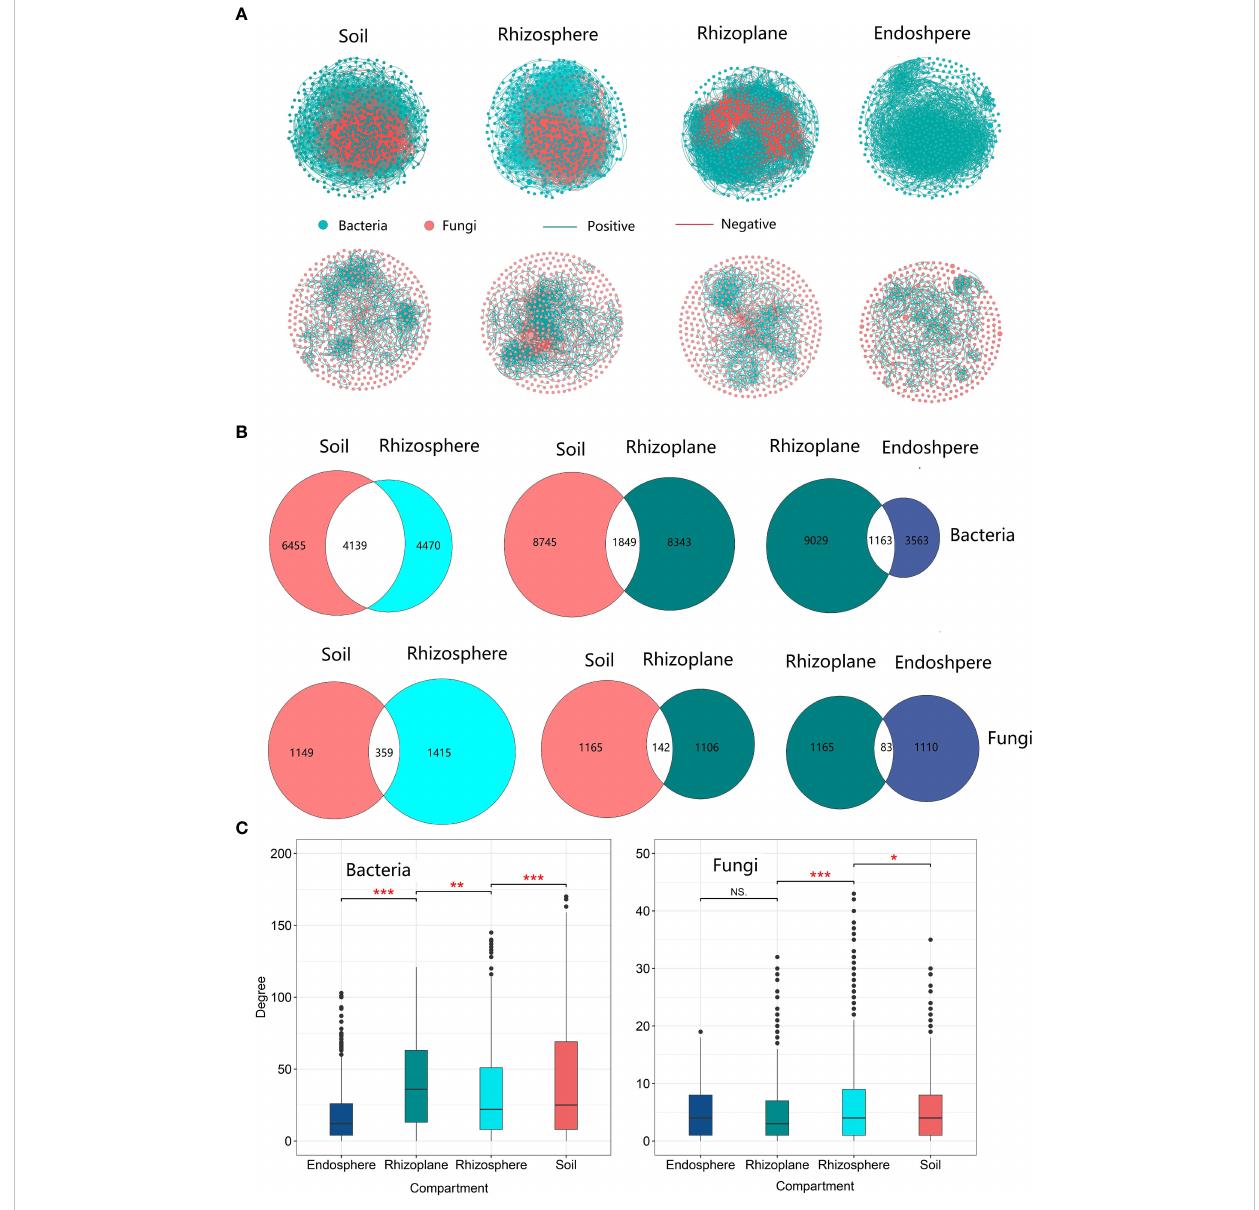
FIGURE 6 The microbial community network structure of different compartments of rubber tree root. (A) : Network of bacterial and fungal communities of different compartments, Green solid circles indicate bacteria; red solid circles indicate fungi. Red lines indicate negative correlation between OTUs, and green lines indicate positive correlations; (B) Number of shared and unique edges of soil bacterial and fungal networks in different compartments. The number where the two circles cross is the number of shared edges; (C) Mean degree of the network for the microbial communities of different compartments. * p < 0.05, ** p < 0.01, *** p <